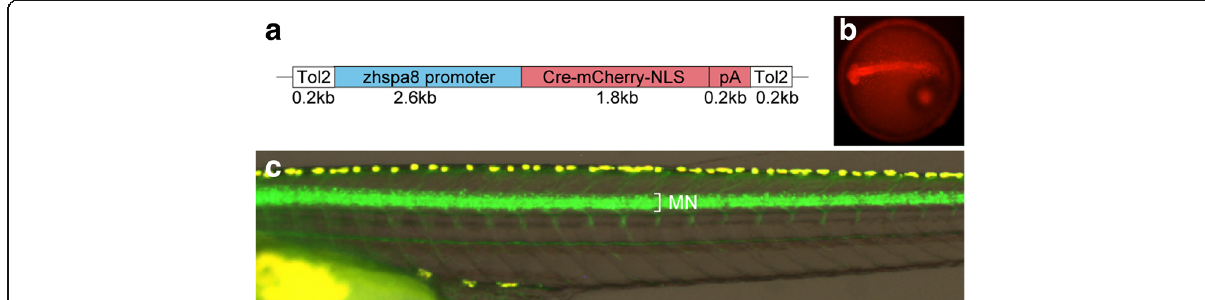
Fig. 2 Generation of Tg[zhspa8:Cre-mCherry-NLS] transgenic fish and conversion of RFP transgenic fish to GFP transgenic fish. ( a ) A schematic of the zhspa8:Cre-mCherry-NLS plasmid. The plasmid consists of the Tol2 left arm (white box), zebrafish hspa8 promoter (zhspa8; blue box), Cre-mCherry-NLS and bovine growth hormone (BGH) polyA signal (red box), and Tol2 right arm (white box). ( b ) A 1dpf embryo of the Tg[hspa8:Cre-mCherry-NLS] transgenic fish. Red fluorescence derived from Cre-mCherry-NLS is present ubiquitously in the embryonic body. ( c ) A 9dpf larva derived from the crossing between Tg[vacht-hs:lRl-GFP] and Tg[hspa8:Cre-mCherry-NLS]. GFP instead of RFP is expressed in the trunk motoneurons